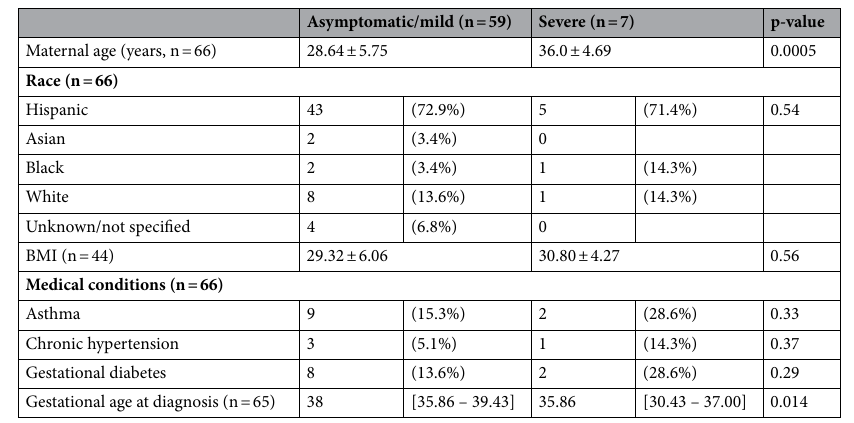
Table 1. Maternal demographics, based on the severity of COVID 19 symptoms. *The categorical values are expressed as n (%), the continuous variables are expressed as either median [IQR] or mean ± SD.